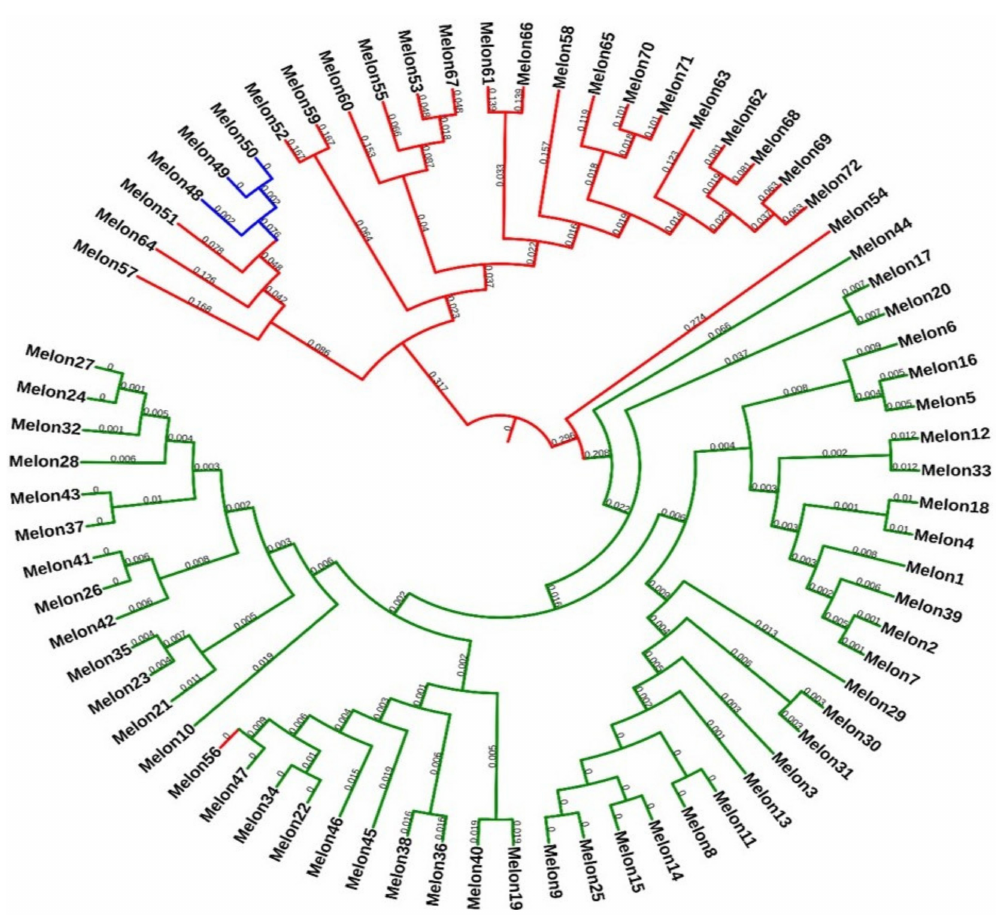
Figure 3. Bayesian phylogenetic tree of 72 accessions of the melon varieties using 6406 single nucleotide polymorphisms (SNPs) (<5% missing data) obtained by genotyping-by-sequencing (GBS). Each color represents three different melon varieties. Numbers in nodes are Bayesian posterior